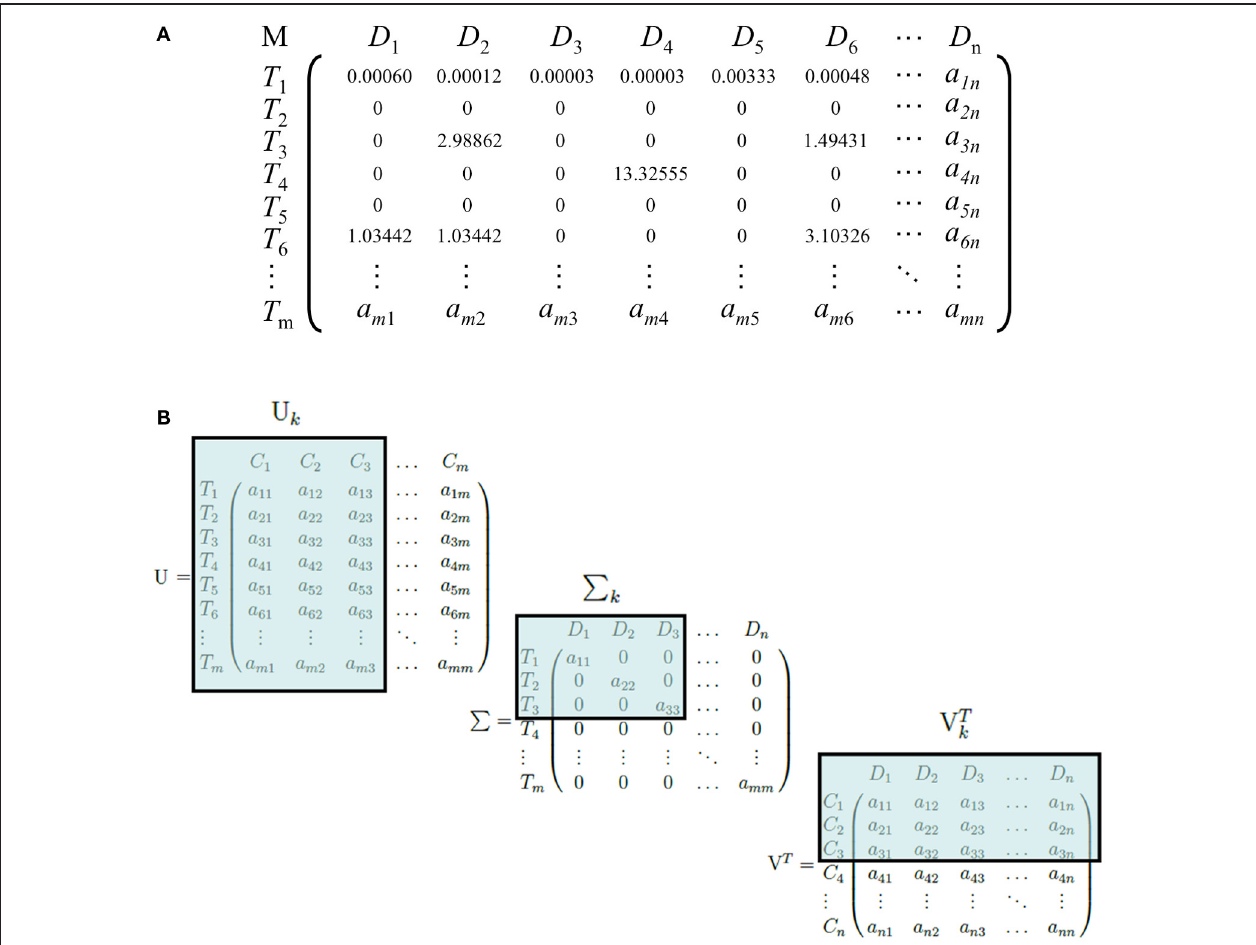
FIGURE 1 | (A) An example of a term-document matrix with a weighting function (tf-idf). M, D, and T refer to the term-document matrix, the set of all documents in the corpus, and the set of all terms in the corpus, respectively.